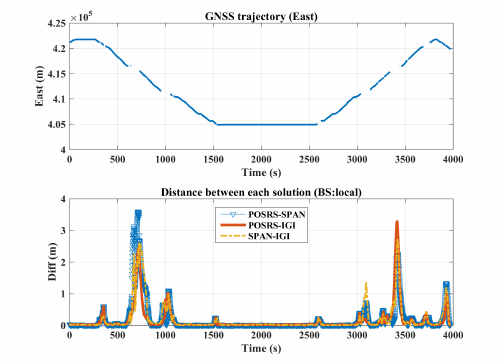
Figure 4: Positioning results from different navigation